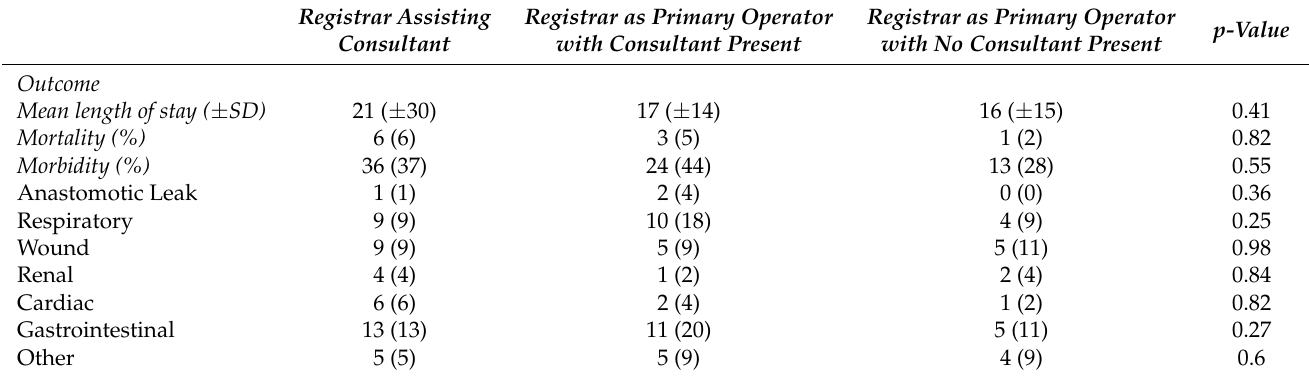
Table 2. Registrar assisting trainer vs registrar as primary operator with trainer present vs registrar as primary operator with no trainer present: